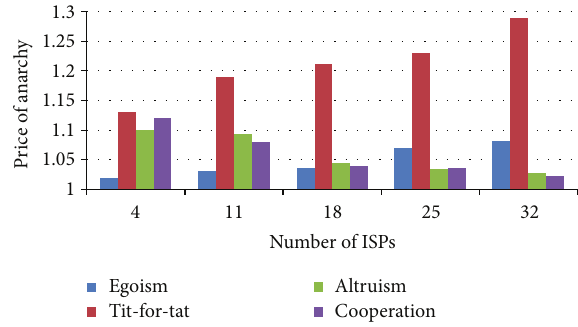
Figure 6: Price of anarchy versus ISP